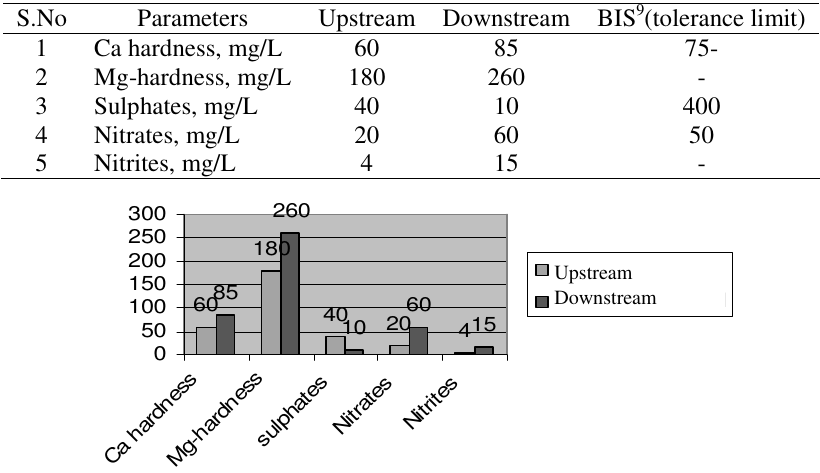
Figure 4. Hardness, sulphates, nitrates and nitrites of upstream and downstream samples represented in